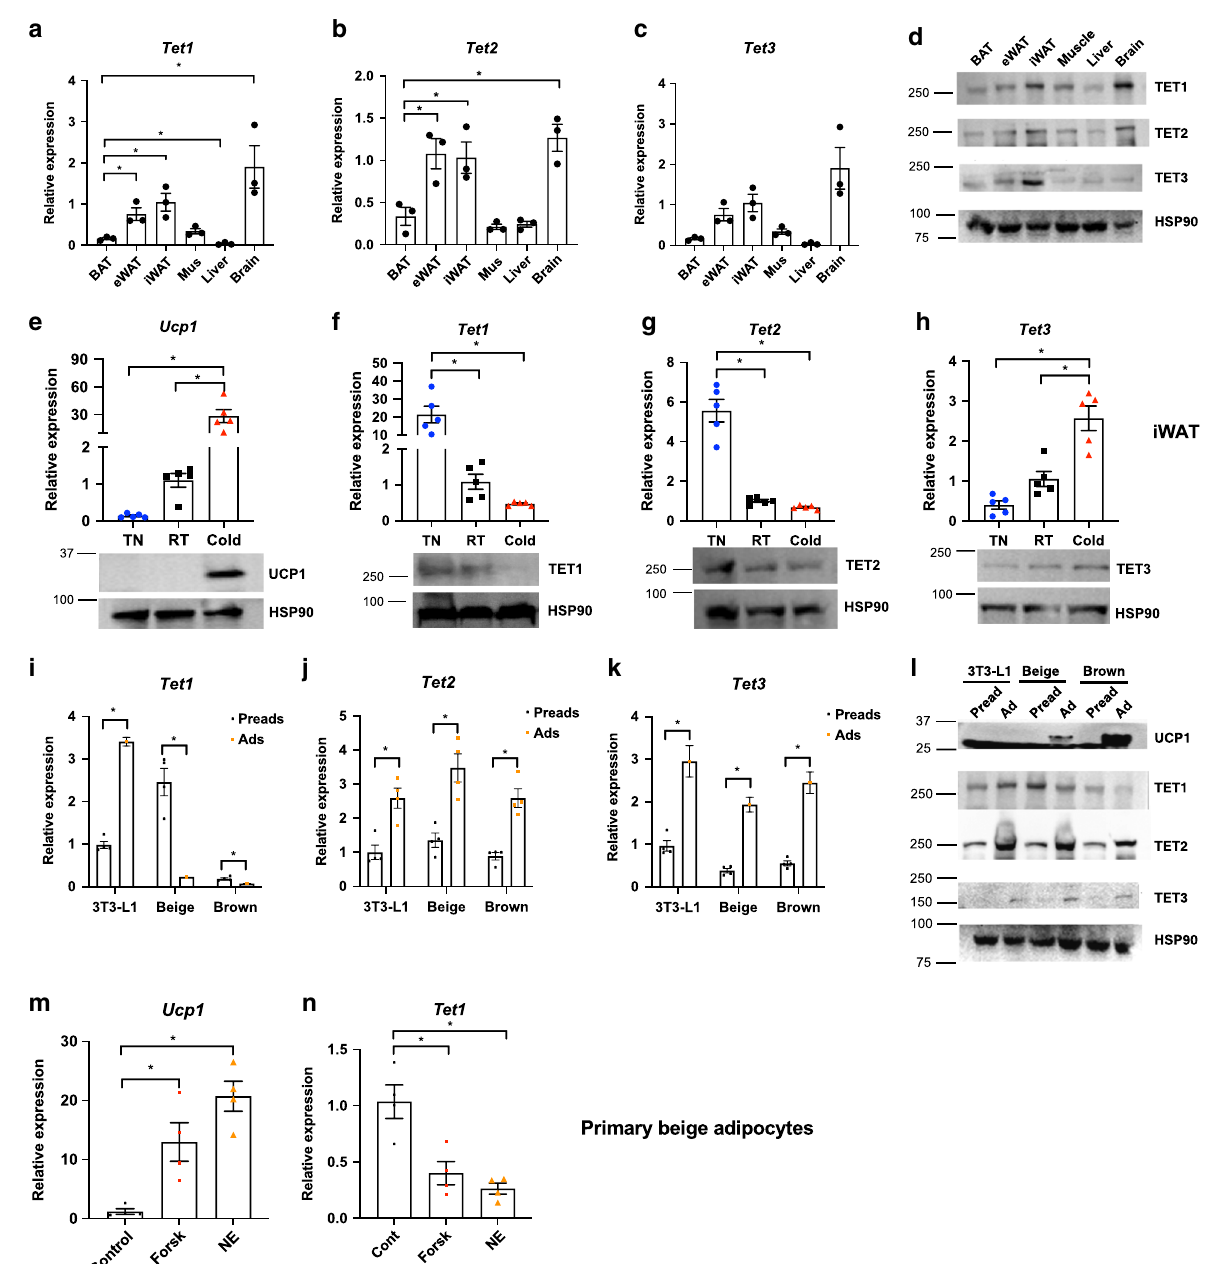
Fig. 1 Subcutaneous adipose Tet1 expression is regulated by ambient temperature and cAMP signaling. a – d Various tissues from wild-type C57BL/6J mice housed at room temperature (RT) were collected to measure Tets mRNA ( a – c ) and protein expression d ( a – c ); n = 3 per group. Data are expressed as means ± SEM. *denotes p < 0.05, determined by two-tailed Student ’ s t test and one-way ANOVA). e – h Tet and Ucp1 mRNA and protein expression in iWAT from wild-type male C57BL/6J mice housed at room temperature (RT) and exposed to cold or thermoneutrality (TN) for 24 h ( n = 5 per group. Data are expressed as means ± SEM. *denotes p < 0.05, determined by two-tailed Student ’ s t test and one-way ANOVA followed by Bonferroni post-hoc testing). i – l Tets mRNA and protein expression were measured in 3T3-L1 and immortalized beige and brown preadipocytes at con fl uence and after differentiation ( i – k ; n = 4 per group. Data are expressed as means± SEM. *denotes p < 0.05, determined by two-tailed Student ’ s t test). m , n Ucp1 and Tet1 mRNA expression with and without 1 μ M forskolin (Forsk) or 1 μ M norepinephrine (NE) stimulation for 3 h in mature primary beige adipocytes ( n = 4 per group, Data are expressed as means ± SEM. *denotes p < 0.05, determined by two-tailed Student ’ s t test and one-way ANOVA followed by Bonferroni post-hoc testing). Source data are provided as a source data fi